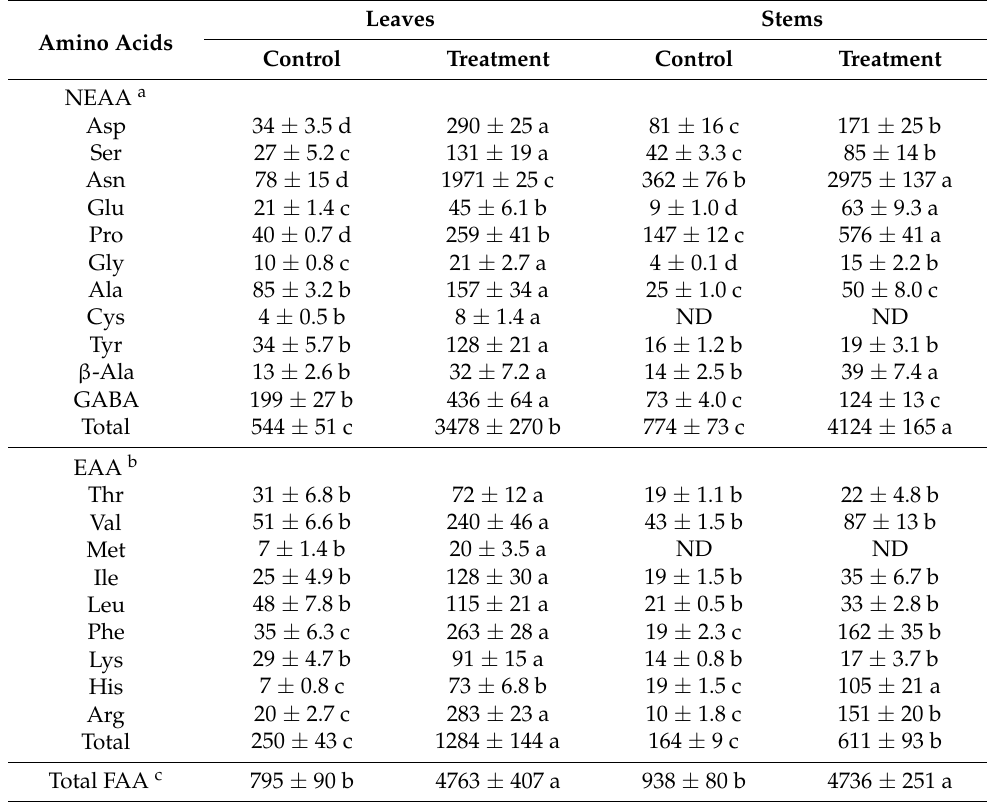
Table 1. Effects of ethylene treatment on free amino acid contents (mg/100 g) in soybean leaves and